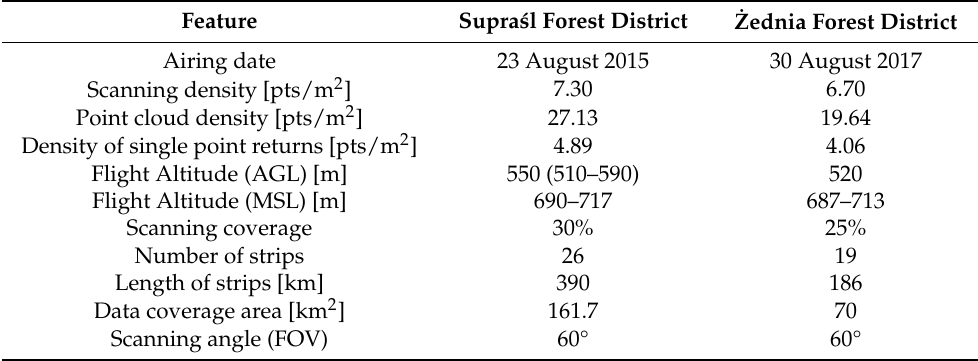
Table 1. Technical parameters of the Airborne Laser Scanning datasets used in this study: airing date, mean scanning density (beams density on the scanning surface), mean point cloud density, mean density of single point returns (density of beams that resulted in a single point return in the dataset), mean flight altitude (both above ground level (AGL) and above mean sea level (MSL)), scanning coverage, number of strips of scanning, length of strips, data coverage area, and scanning angle (field of view